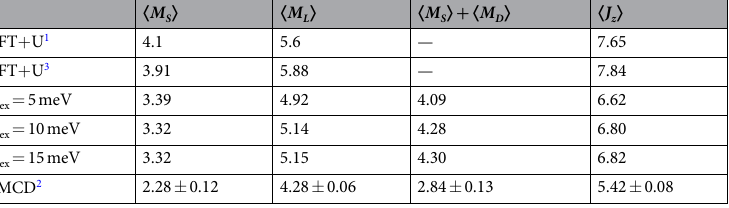
Table 1. Spin ( M S ), orbital ( M L ), M S plus magnetic dipole M D moments (in μ B ), and the total 〈 J z 〉 = M S /2 + M L for the fcc -Ho adatom on Pt(111) with different values of the exchange splitting Δ ex , in comparison with DFT + U 1, 3 and experimental data 2